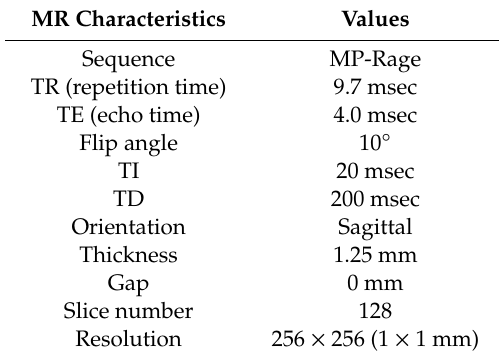
Table 3. Magnetic resonance imaging (MRI) acquisition details